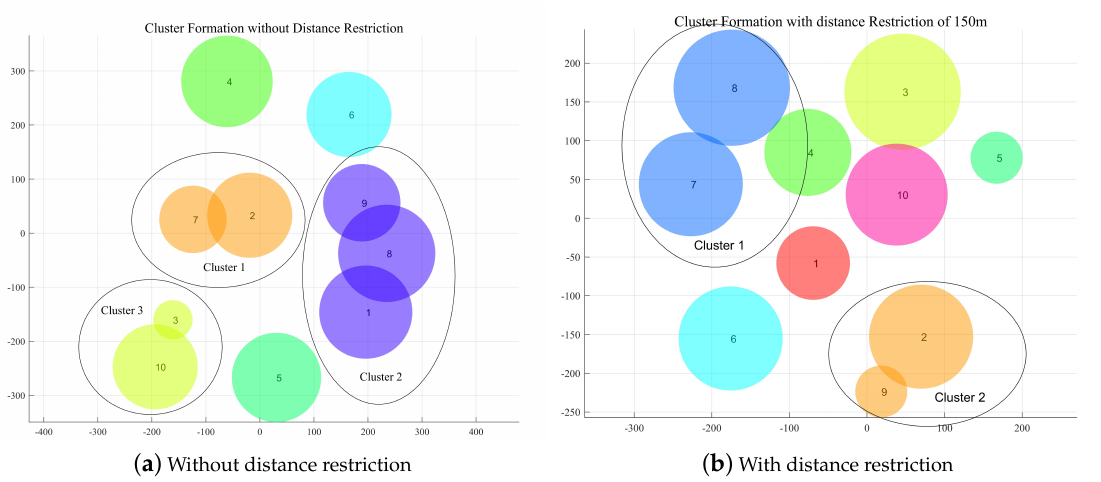
Figure 4. Comparison of cluster result for two cases: with and without minimum distance restriction. ( a ): Without distance restriction; ( b ) With distance